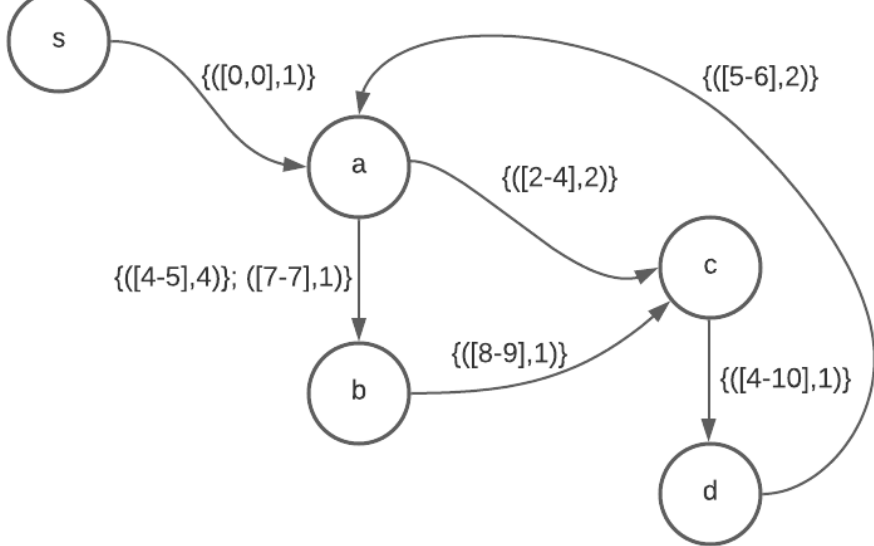
Figure 4. Example of mwf walks from source vertex s